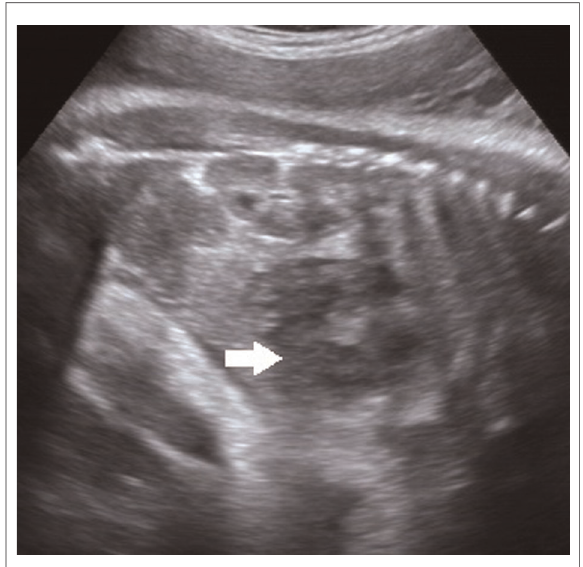
FIGURE 1 A well-de fi ned 46 mm×29 mm mixed mass at the lower margin of the right lobe and in front of the right kidney, which is polycystic with uneven internal echo. Arrows point to the